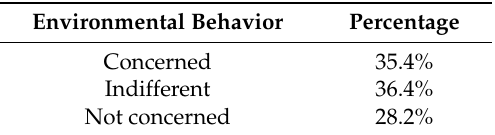
Table 9. Environmental performance assessment based on the